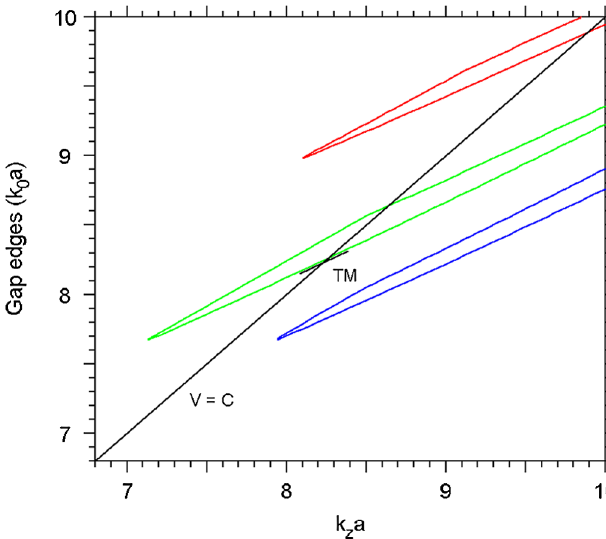
FIG. 9. Band gap diagram of the 9.8-micron period fiber (defect R=a ¼ 0 : 463 , lattice hole r=a ¼ 0 : 363 ) fabricated by Incom Inc. showing location of TM accelerating mode as calcu- lated with BANDSOLVE .